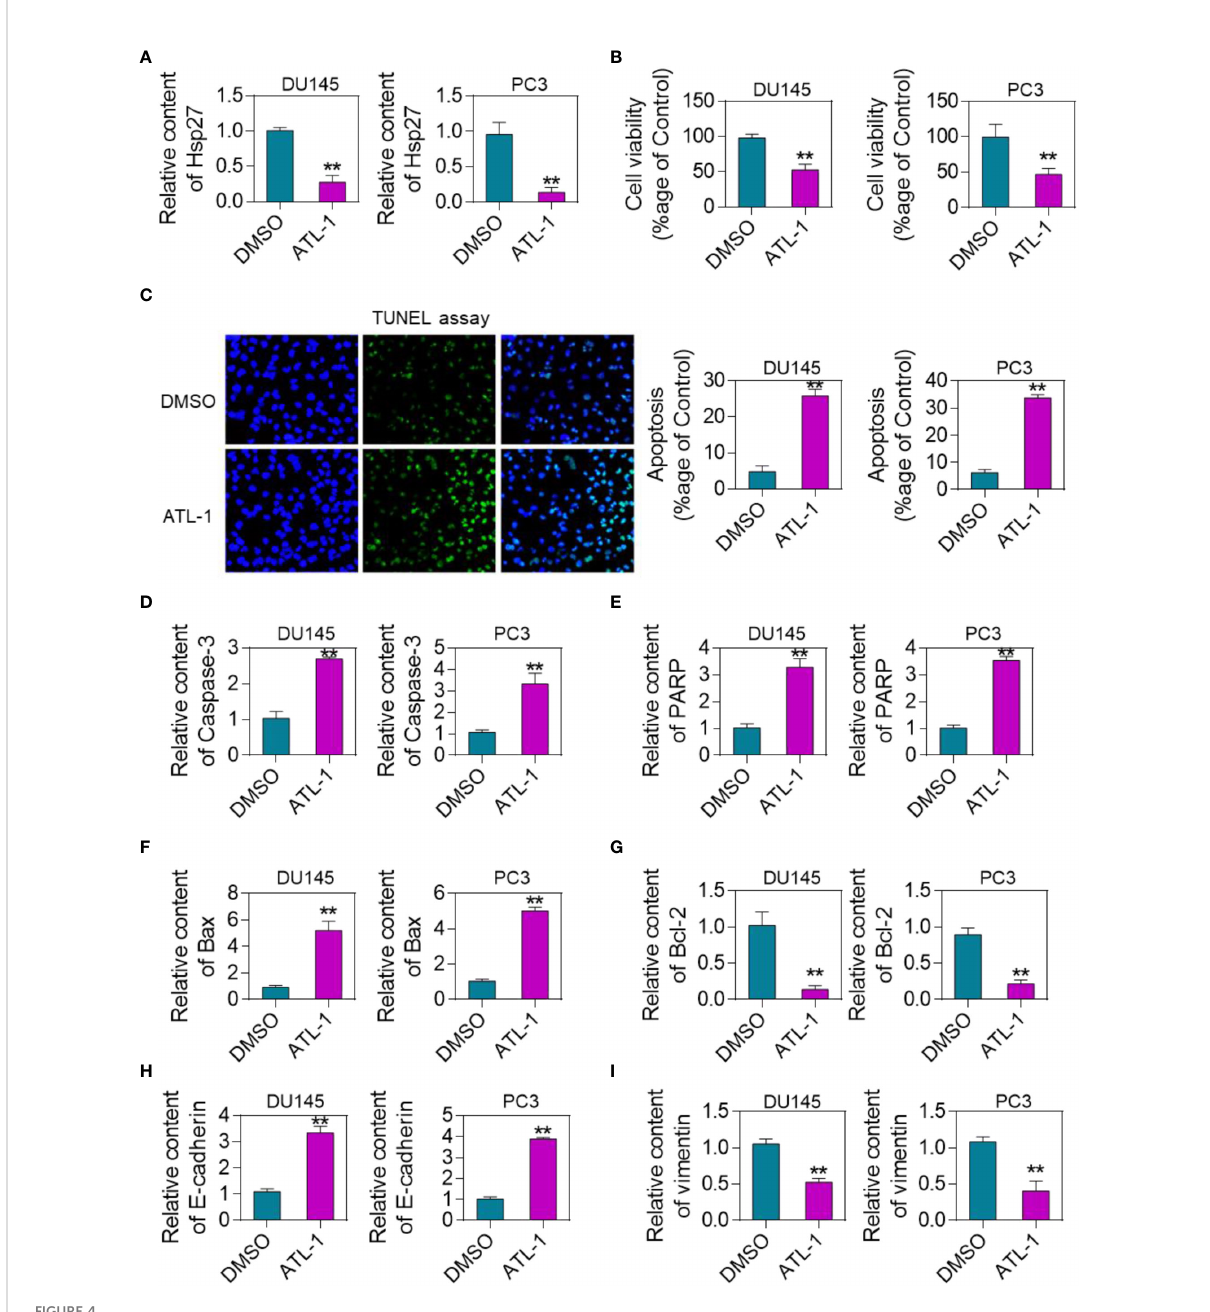
FIGURE 4 Inhibition of Hsp27 by ATL-1 reduces cell viability and induces apoptosis. (A) qRT-PCR analysis of Hsp27 expression levels in DU145 and PC-3 cells treated with ATL-1 or DMSO. (B) MTT assay to quantify the viability of ATL-1 or DMSO-treated DU145 and PC-3 cells. (C) TUNEL assay to detect the apoptosis of DU145 and PC-3 cells treated with ATL-1 or DMSO. Results are expressed as a percentage. 200× (D) qRT-PCR analysis of the expression level of apoptosis-related gene caspase-3 in DU145 and PC-3 cells treated with ATL-1 or DMSO. (E) qRT-PCR analysis of the expression levels of apoptosis-related gene PARP in ATL-1 or DMSO-treated DU145 and PC-3 cells. (F) qRT-PCR analysis of the expression level of apoptosis-related gene Bax in DU145 and PC-3 cells treated with ATL-1 or DMSO. (G) qRT-PCR analysis of the expression level of apoptosis- related gene Bcl-2 in DU145 and PC-3 cells treated with ATL-1 or DMSO. **P <0.01 by two-tailed Student ’ s t-test. (H) qRT-PCR analysis of the expression level of E-cadherin in DU145 and PC-3 cells treated with ATL-1 or DMSO. (I) qRT-PCR analysis of the expression level of Vimentin in DU145 and PC-3 cells treated with ATL-1 or